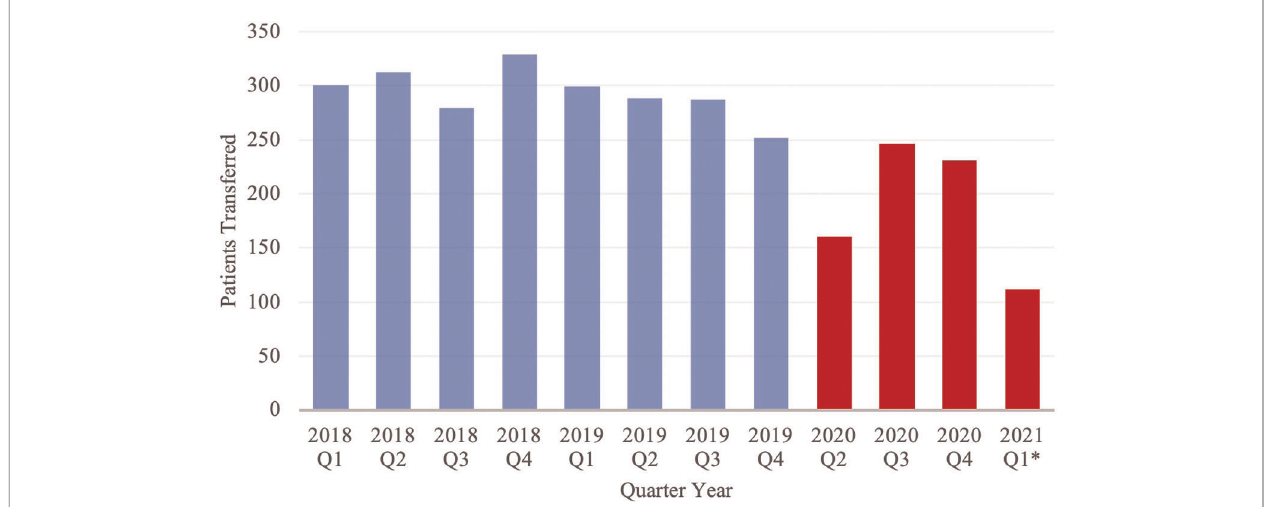
FIGURE 1 | Volume of Neuroemergent Patient Transfers, strati fi ed by Quarter Year. Blue and red columns represent data from the PCOV and COVID cohorts, respectively. *Note: Data from 2020 Q1 has been excluded from the study; Data from 2021 Q1 only includes the months of January and February.